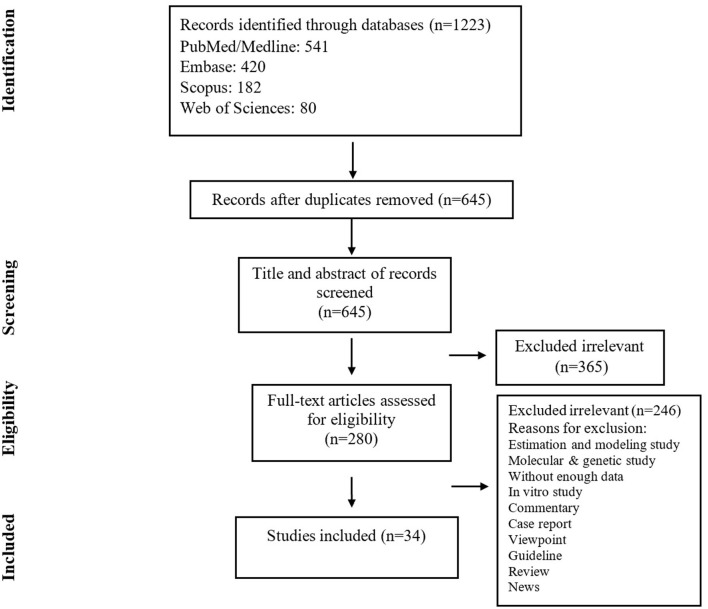
Flow chart of study selection for inclusion in the systematic review and meta-analysis.